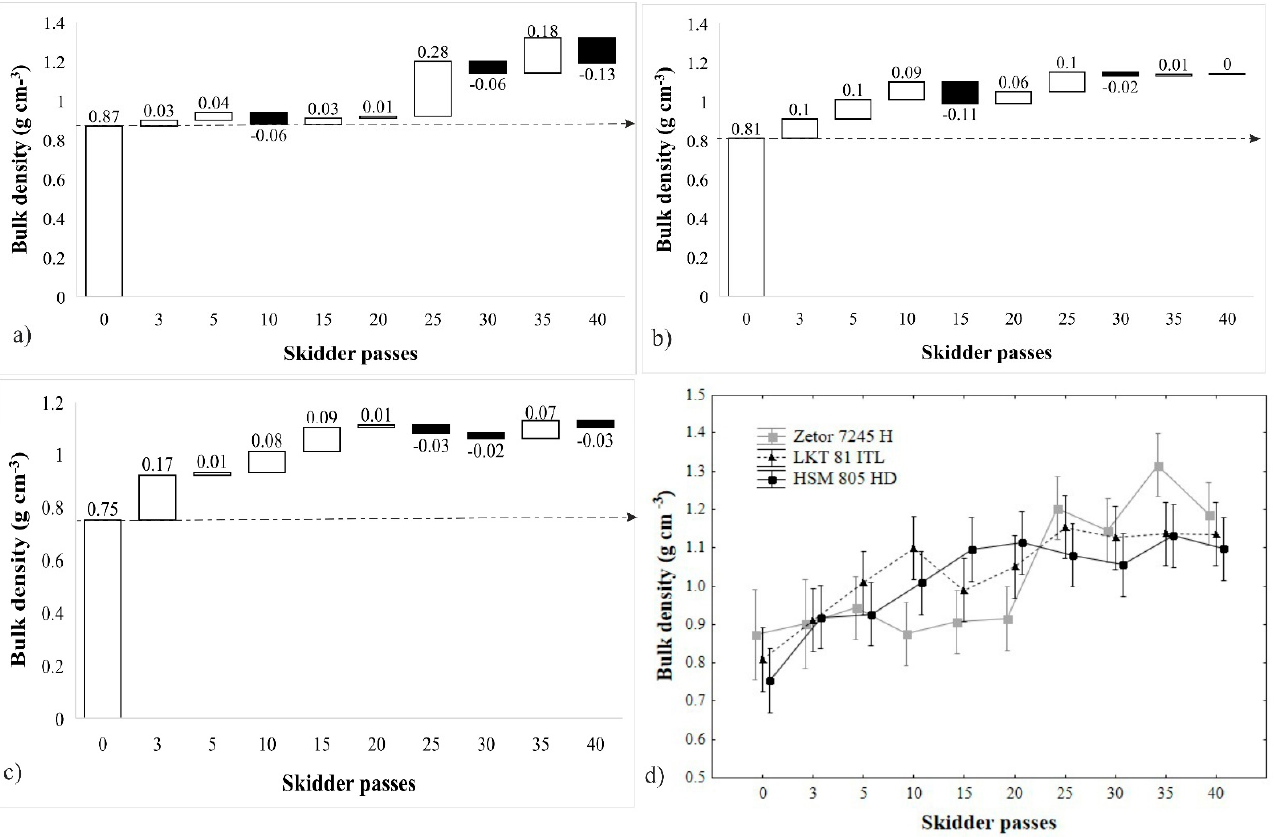
Figure 2 . Comparison of the differences ( Δ ) of increase or decrease of bulk density (g cm − 3 ) at different numbers of the universal skidder ( a ), the LKT forest skidder ( b ), and HSM forest skidder ( c ); average soil bulk density (g cm − 3 ) for individual machine passes of the machines, vertical lines depicting 95% confidence intervals ( d ). Black bar color (subfigures ( a – c )) indicates a decrease in bulk density. Table 5. Comparison of initial and final bulk densities (g cm − 3 ) at the experimental plots subjected to traffic by particular machines; U.S.—universal skidder Zetor 7245, F.S.1—forest skidder LKT 81 ITL, F.S.2—forest skidder HSM 805